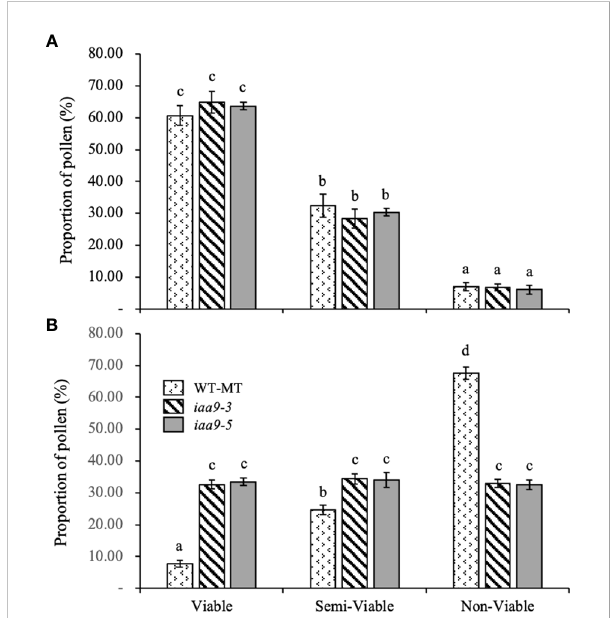
FIGURE 4 The proportion of pollen of WT-MT, iaa9-3 and iaa9-5 under two temperature conditions, i.e., (A) normal temperature and (B) heat stress condition. The average value ± standard error (SE) (n = 4) followed by the same lowercase letters is not signi fi cantly different based on Duncan ’ s Multiple Range Test at 5%.